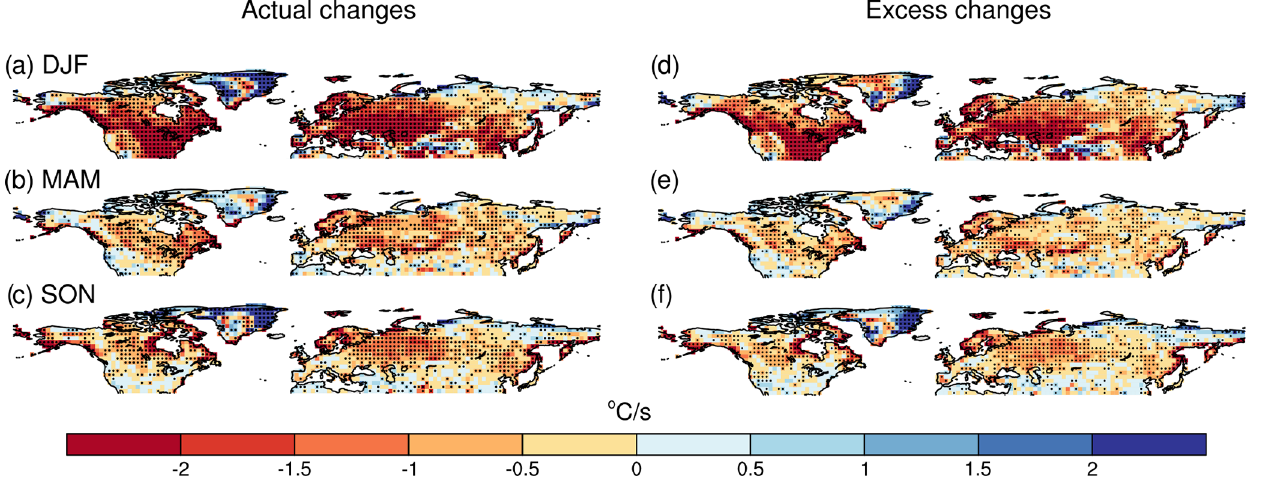
Figure 3. Projected future changes (2070–2099 to 1950–1979) in actual (a–c) and excess (d–f) negative temperature advection in ◦ Cs − 1 in the six-member CMIP5 multi-model mean for boreal winter (a, d) , spring (b, e) and autumn (c, f) . Changes are calculated using the average negative temperature advection for the 3d prior to the day the seasonal minimum occurs, with negative values indicating reductions in cold air advections and positive values indicating